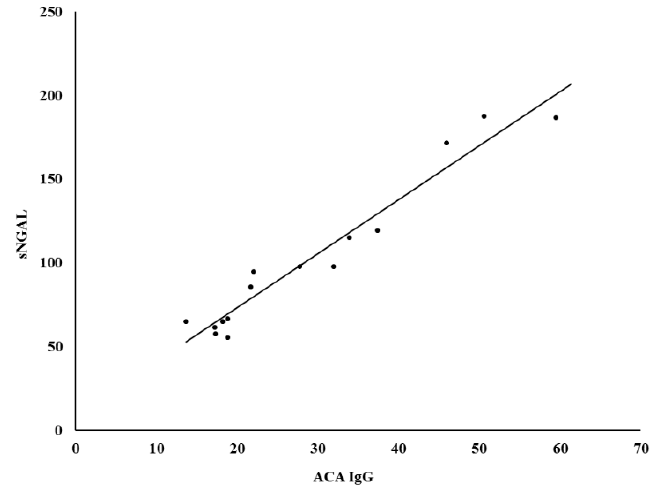
Figure 1. Correlation between sNGAL and ACA antibodies. sNGAL—serum Neutrophil gelatinase- associated lipocalin, ACA IgG—anticardiolipin antibodies type G.